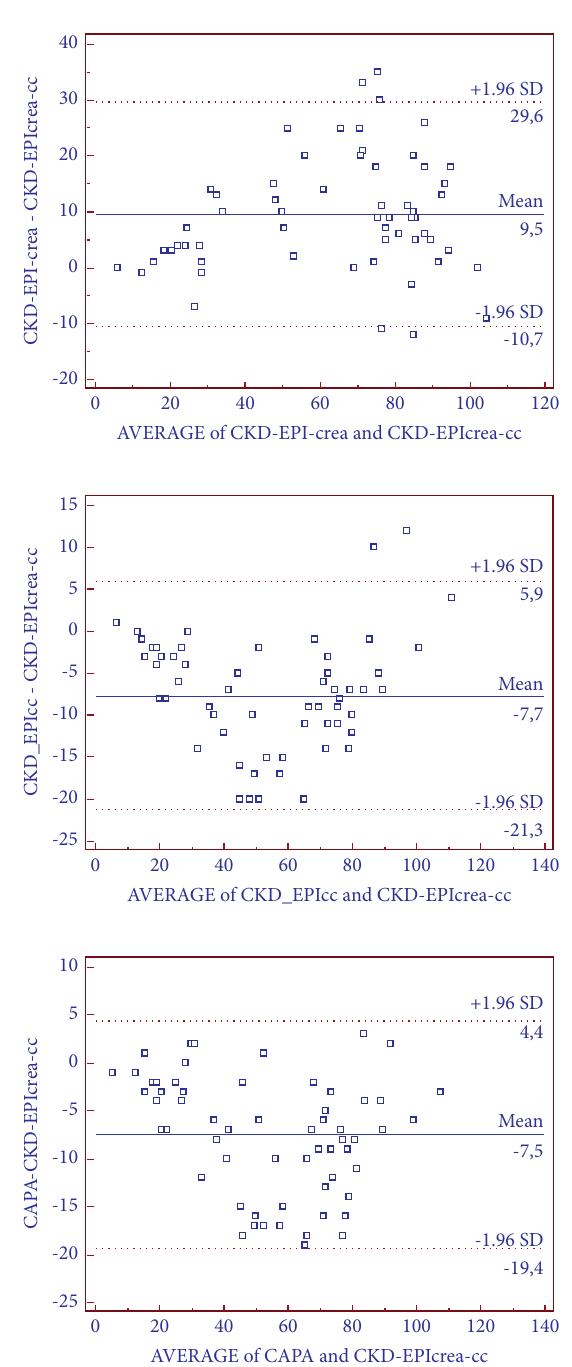
Figure 2: Comparison of CKD-EPI-creatinine, CKD-EPI-cystatin C, and CAPA equations with CKD-EPI-crea-CysC equation (using with reference method according to KDIGO guidelines) in newly diagnosed multiple myeloma